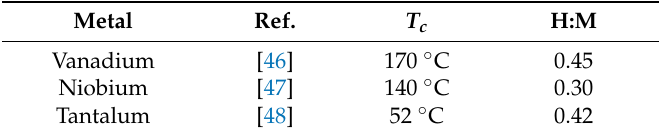
Table 2. Critical temperatures T c and corresponding H:M ratio for selected metals. Metal